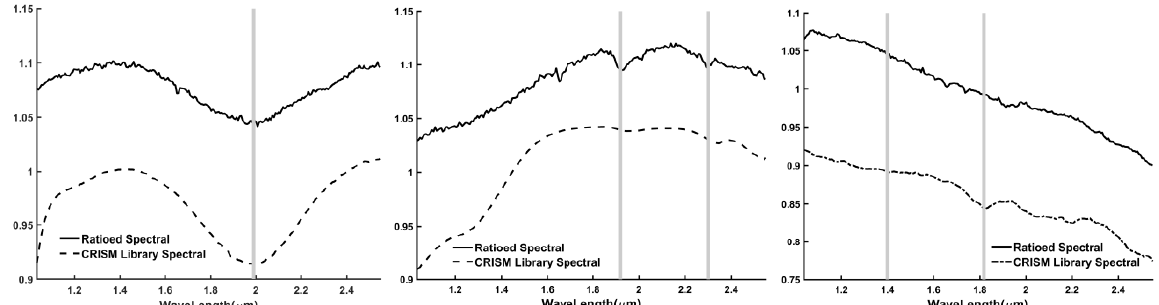
Figure 3. Ratioed spectra and CRISM library spectral from pyroxene(a), siderite(b) and diaspore(c) respective. The grey vertical lines indicate different absorpation